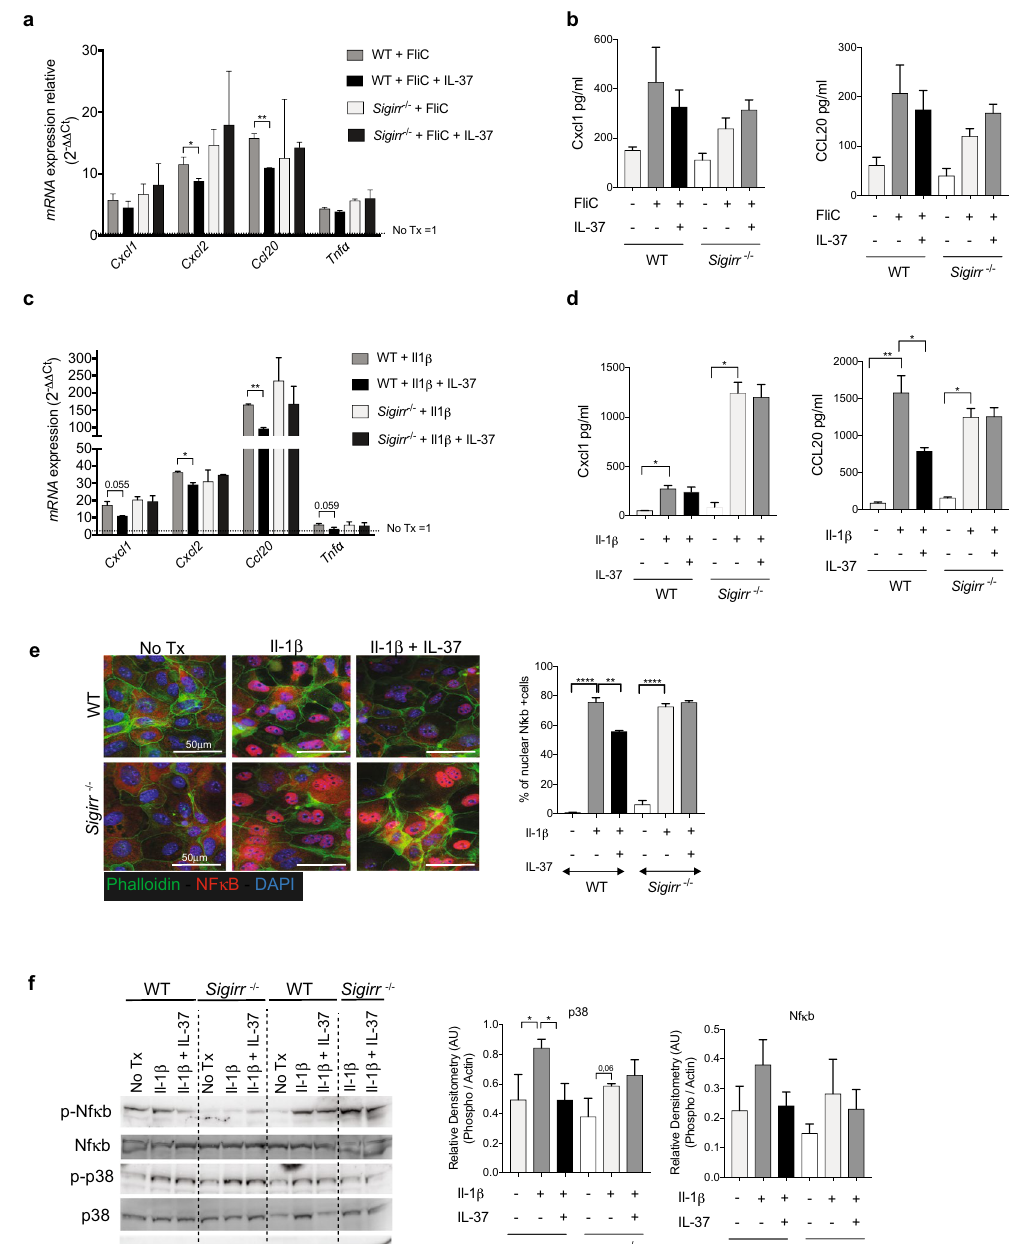
Figure 5. IL-37 ′ s suppression of innate responses in mouse organoids is Sigirr dependent. ( a ) qPCR analysis of main inflammatory genes after FliC stimulation with IL-37 for 4 h on Sigirr +/+ ( WT) and Sigirr −/− mouse colonoids expressed as fold change over untreated colonoids. ( b ) Cxcl1 (left) and Ccl20 (right) protein levels secreted basolaterally by WT and Sigirr −/− mouse colonoids after 4 h of stimulation with FliC and IL-37. ( c ) qPCR analysis of key inflammatory genes after with Il-1β stimulation, in concert with IL-37 for 4 h on Sigirr +/+ (WT) and Sigirr −/− mouse colonoids expressed as fold change over untreated colonoids. ( d ) Cxcl1 (left) and Ccl20 (right) protein levels secreted basolaterally by WT and Sigirr −/− mouse colonoids after 4 h of stimulation with Il-1β and IL-37. ( e ) Immunostaining against Nfkb (red), Actin Phalloidin (green) and DAPI (blue) of 2D monolayer after 30 min of stimulation with Il-1b with or without IL-37 (left). Counts of Nfkb positive nuclei from immunostaining (Right). ( f ) Western blot analysis of phospho and total NFkB, phospho and total p38 in mouse colonoids after 30 min of stimulation with Il-1β with or without IL-37 (left). Equal loading was confirmed with β-Actin as well as total protein stain of membrane (see Fig. S6 online). Densities relative to total protein or β-Actin are shown (right). Mean and SEM are indicated from n = 4 mouse organoid lines derived from each genotype. All data shown are representative of at least 3 independent experiments. Statistical significance calculated using one-way ANOVA *, P = 0.01 to 0.05; **, P = 0.001 to 0.01; ***, P = 0.0001 to 0.001; ***, P = 0.00001 to 0.0001. Comparison lacking annotations are not